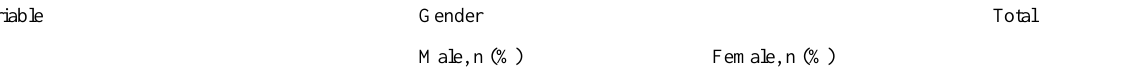
Table 8. Accounting some questions according to gender of participants